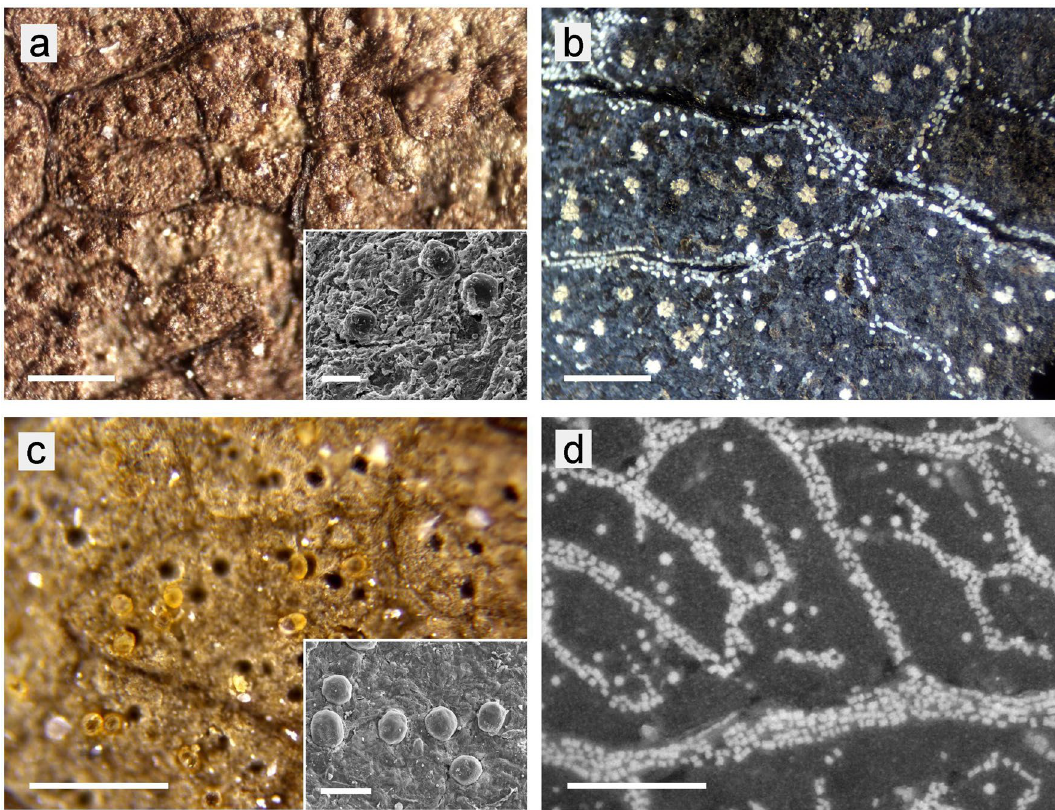
Figure 2. Globular structures in fossil leaves in comparison with CaOx druses of fresh leaves. LM images; surface illumination, 10 × objective. ( a ) Fossil sample Ro-90_1 ( Quercus neriifolia ) with large brown globules; the inserted SEM image shows globules in detail. ( b ) druses of various size and small crystals in a burnt leaf of Quercus variabilis . ( c ) Fossil sample Ro-100_5 ( Salix longa ) with yellow transparent globules and many empty cavities, which remained when globules were pulled out during splitting the fossil. ( d ) Druses and crystals in a burnt leaf of Salix miyabeana . Scale bars: ( a – d ) = 200 µm; insets ( a , c ) = 40 sil leaf samples. The sizes of the particles, typically 20–40 µm, match well the sizes of CaOx druses in leaves of extant species, as demonstrated in Fig. 2 with the fossil samples Ro-90_1 (assigned to Quercus neriifolia ) and Ro-100_5 ( Salix longa ) (Fig. 2a,c) in comparison with leaves from extant Quercus and Salix species (Fig. 2b,d). However, sizes of up to 100 µm were found for globules in other fossil samples, as well as for CaOx druses of certain extant species (Table 2). Figure 3 shows various distinctive patterns of granular structures in Rott fossils that are apparent in LM and SEM images. Yellow-to-brown globules in areoles between brown leaf veins (Fig. 3a) are clearly visible contrasting in colour against white background of diatomitic sediment in fossil no. ‘Ro-2.2’ (‘ Sideroxylon salicites ’). Com- positional contrast (BSE) SEM image (Fig. 3b) shows fragmented granules embedded in sediment, indicating they differ in chemical compositions. Dark appearance of granules in the SEM image indicates they are organic material, whereas background sediment is a mix of organic and mineral (bright) components. In several leafy coal bed-based samples like ‘Ro-110.6’ (‘Magnoliopsida’), brown globules, which were on brown organic background between dark brown veins, were more difficult to recognise and distinguish from background by LM due to low colour contrast. Lateral illumination made them more easily visible because most of the globules projected above the level of surrounding leaf area. Globules and a corresponding number of cavi- ties were present in cleaved samples. In ‘Ro-110.6’ (Fig. 3c) globules were evenly dispersed across leaf surface, as often observed in fresh leaves. Brick-like structures in veins appear similar to CaOx crystal patterns along the veins of fresh leaves (Fig. 3d). Sizes of the globular structures may be either variable, as in ‘Ro-2.2’ (Fig. 3a), or nearly uniform. Both variable and uniform sizes were also found as common patterns in CaOx druses in fresh plant leaves; e.g., in Hedera helix . Black serrated particles on a mineral background occur on the whole surface of a large leaf on specimen ‘Ro-13.3’ (‘ Nymphaea nymphaeoides ’) (Fig. 3e,f) and also on some other specimens [Ro-106.1 (‘ Nyssa rottensis ’, Ro-58.5 (‘ Zizyphus zizyphoides ’)]. The size and shape of the serrated granules resemble CaOx druses which are found in many fresh leaves. Smaller yellow globules between the black granules are difficult to recognise under the LM due to low contrast and also by SEM due to the heterogeneous structure of the surrounding area. Freshly cleaved areas of the leafy coal bed sample ‘Ro-59.9’ (Fig. 3g,h) showed numerous empty cavities which resembled CaOx druses of fresh leaves in size and distribution. The polygonal shape corresponds to the angular